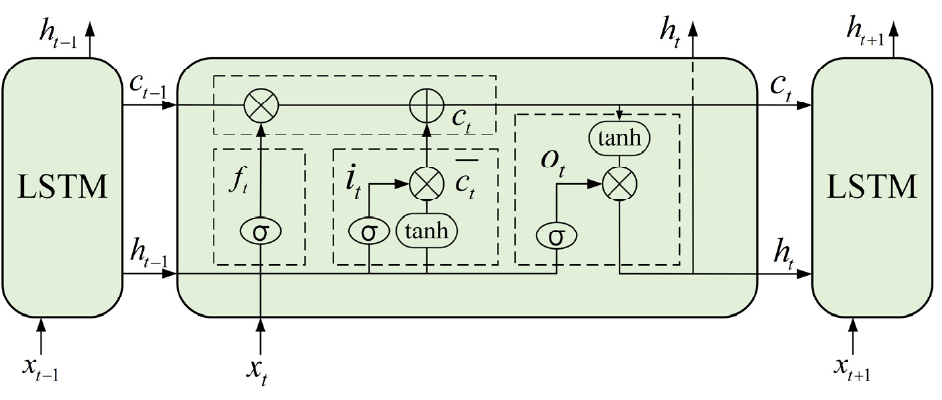
Figure 8. LSTM neural unit structure.